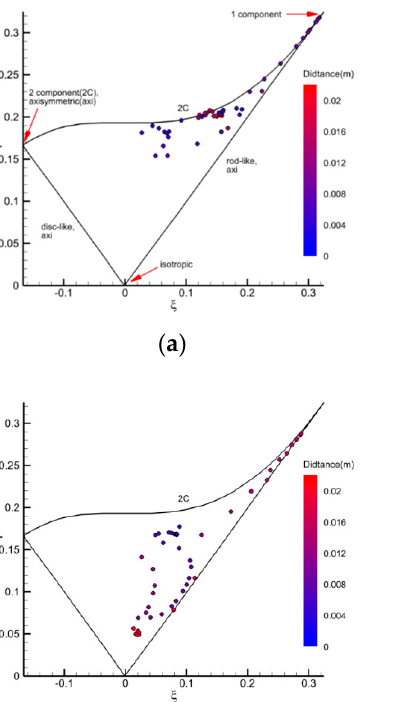
lines at 10%, 20%, and 30% span.